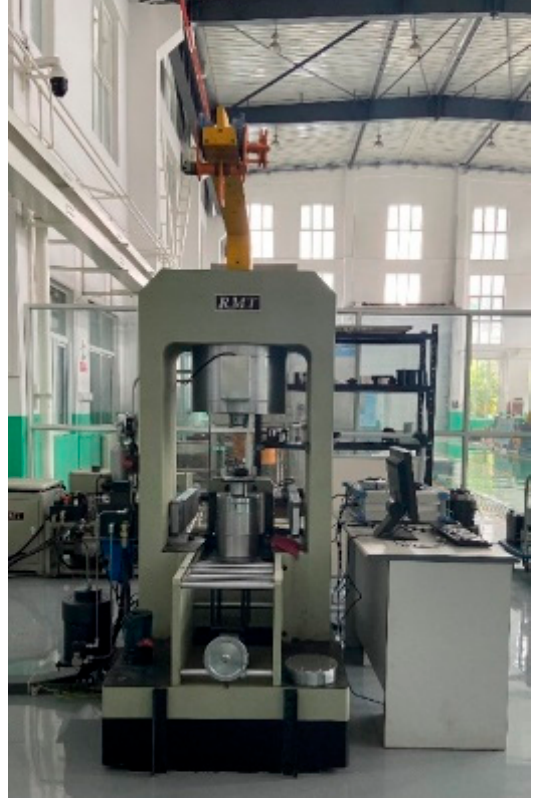
Figure 3. RMT-301 rock and concrete mechanics experimental system.